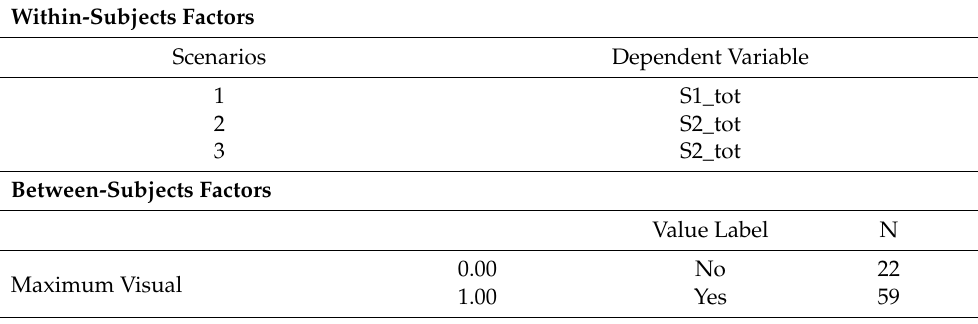
Table 4. Factors and descriptive